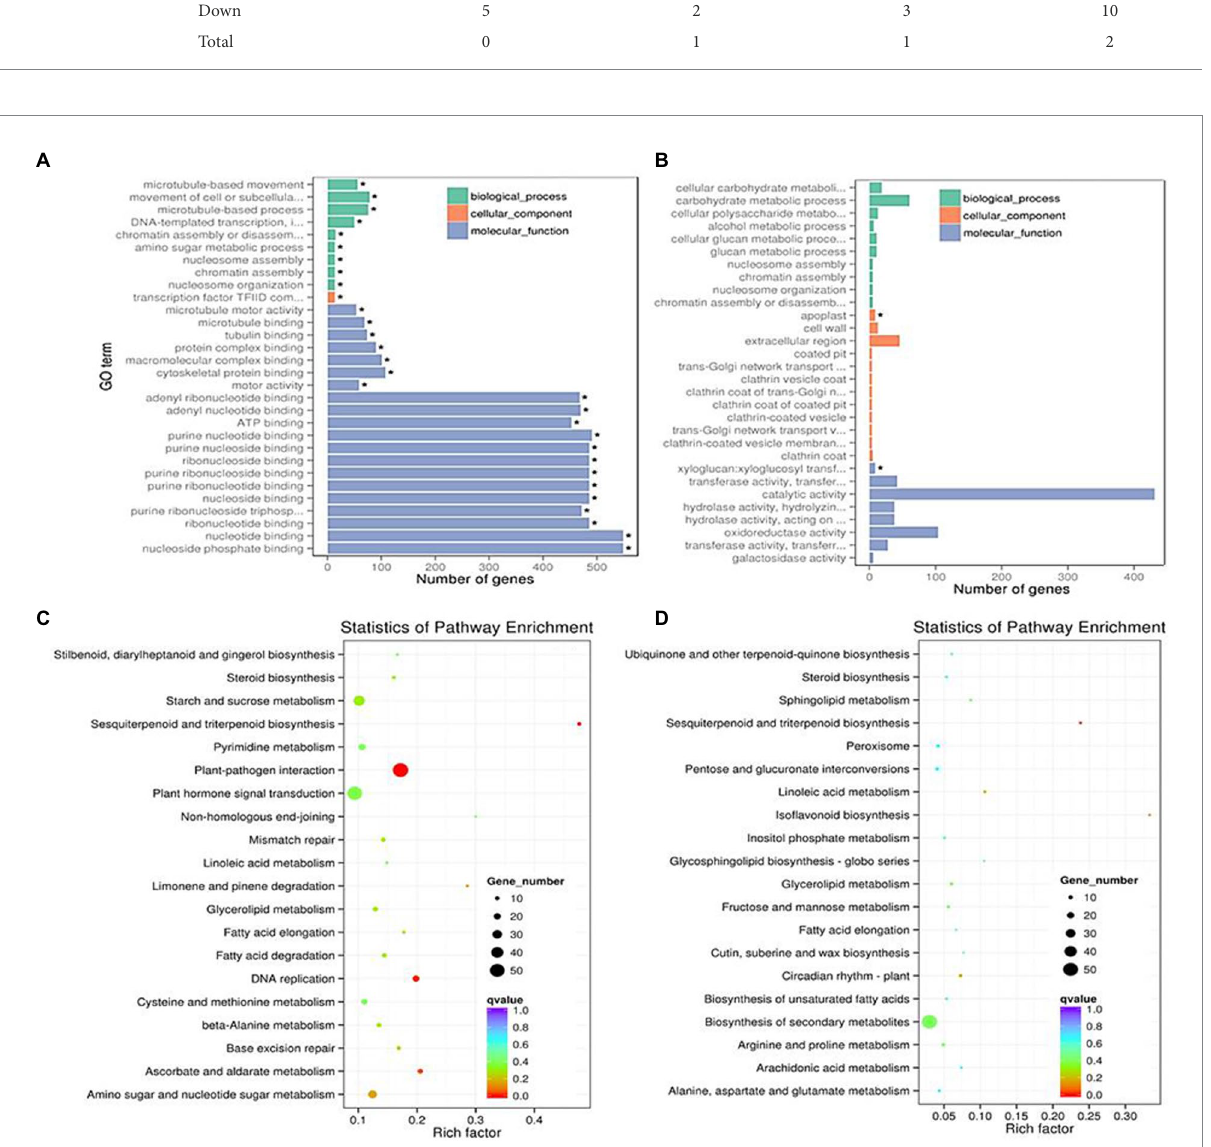
FIGURE 6 The most enriched GO terms in LD (A) and SD (B) and KEGG pathway terms in LD (C) and SD (D)